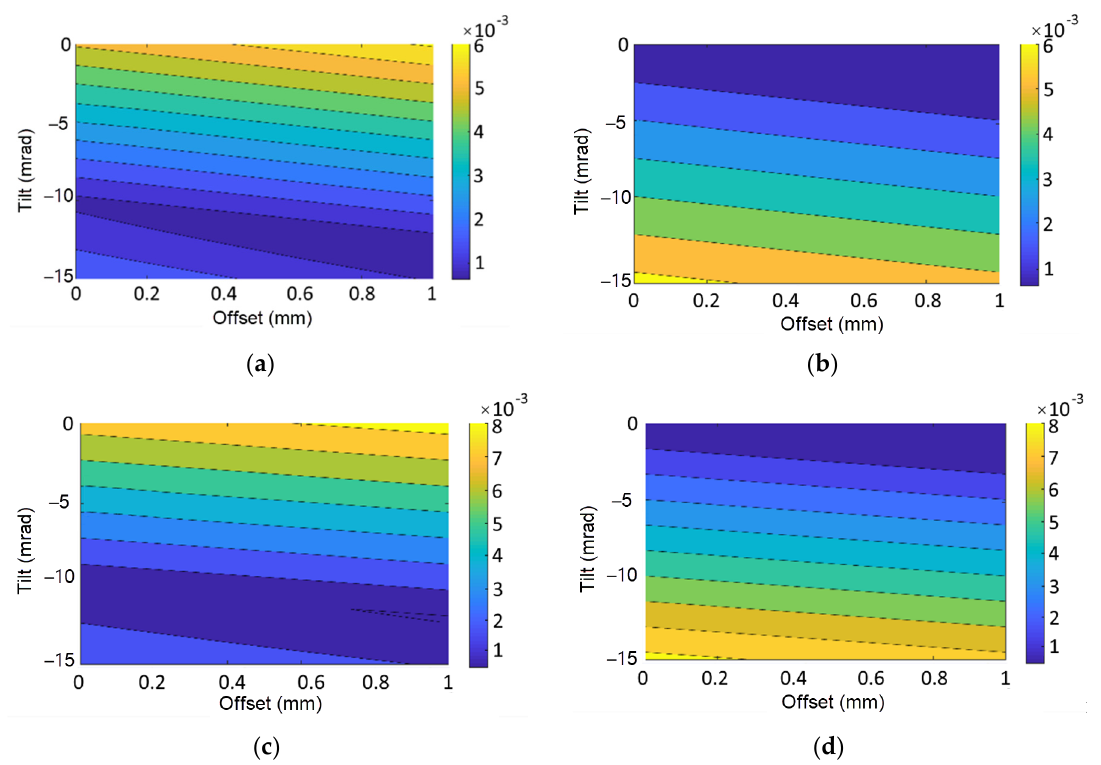
Figure 7. Exit offset spectrum over injection parameters for kicked ( a , c ) and unkicked ( b , d ) bunches with the lengths of 400 mm ( a , b ) and 600 mm ( c , d ).